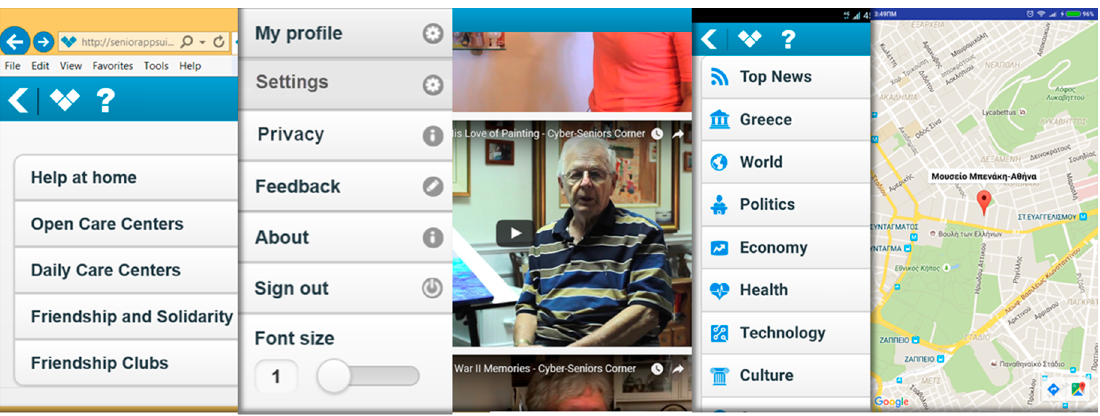
Figure 10. Screens of information services.